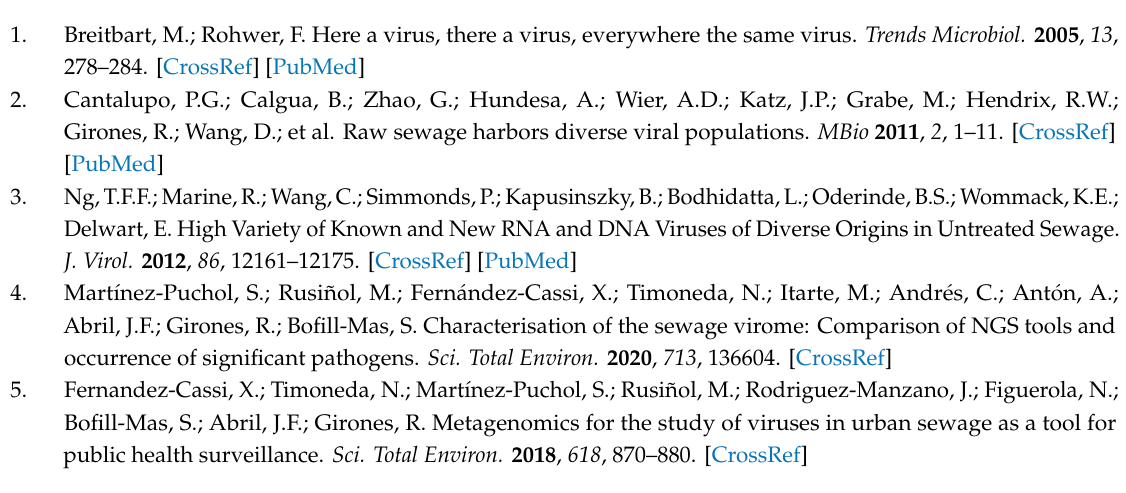
Supplementary Table S1: Summary information about sequencing depth, quality filtering, read mapping and assembly of Trebal RNA viral metagenome, Supplementary Table S2: Relative abundances of viral families classified by LCA algorithm trough local alignment to NCBI nr database, Supplementary Table S3: Frequency of ribosomal binding site (RBS) motifs found in 31 Picobirnaviridae RNA-dependent RNA polymerase (RdRP) predicted